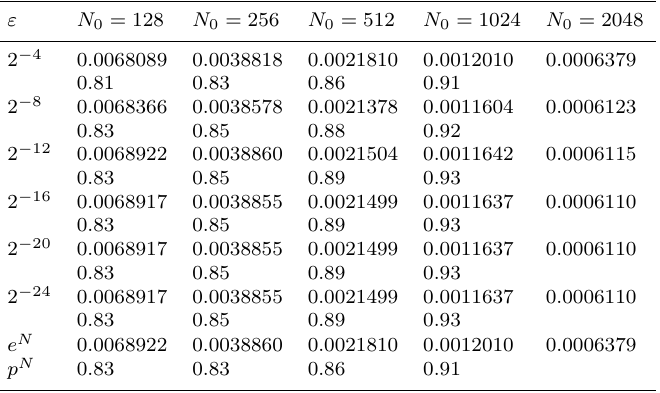
Table 1. Computed errors and convergence rates of the test problem ε N 0 = 128 N 0 = 256 N 0 = 512 N 0 = 1024 N 0 = 2048 2 −